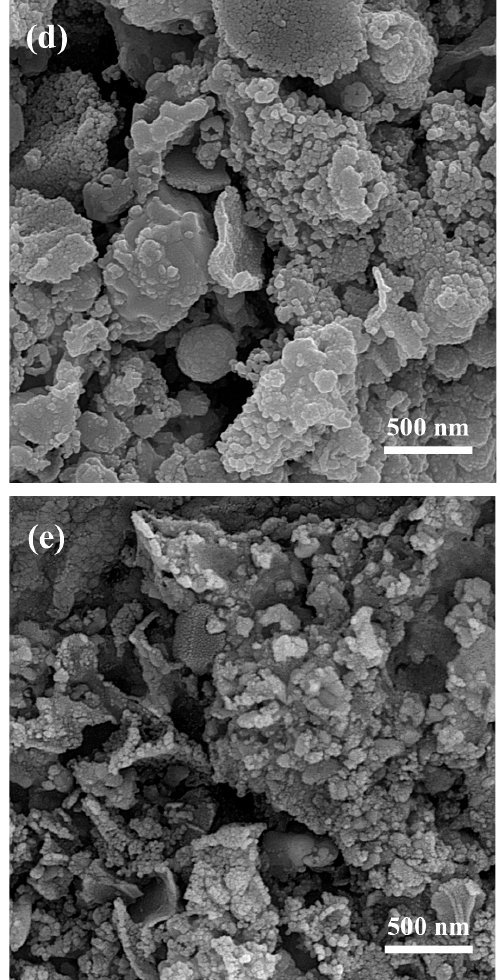
Figure 4. SEM image of ( a ) the cross-section of the SCFG/SDC/SCFG symmetrical cell created by SCFG fibers; ( b – e ) the typical section of SCFG cathode with fibrous structure before/after infiltration of about 7, 14, and 21 wt% of SDC nanoparticles, respectively .